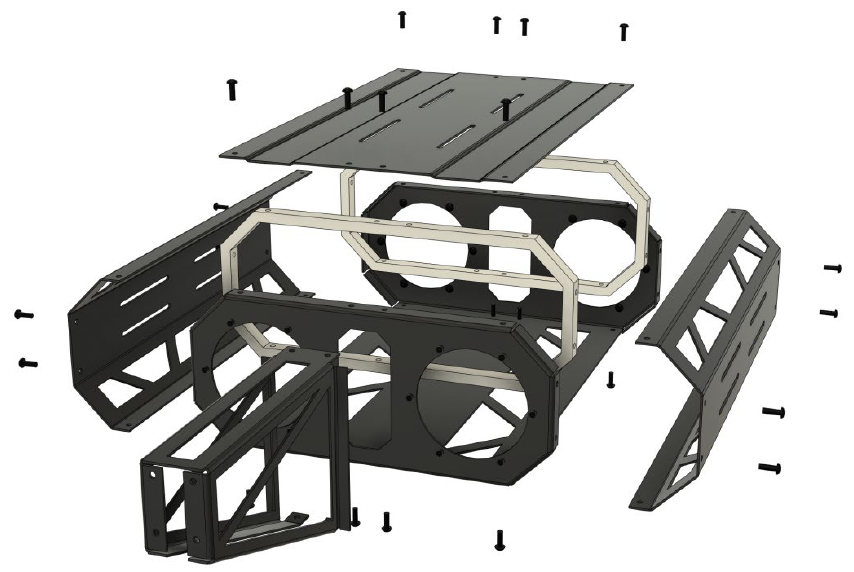
Figure 7. Exploded view of the structure of the torso.